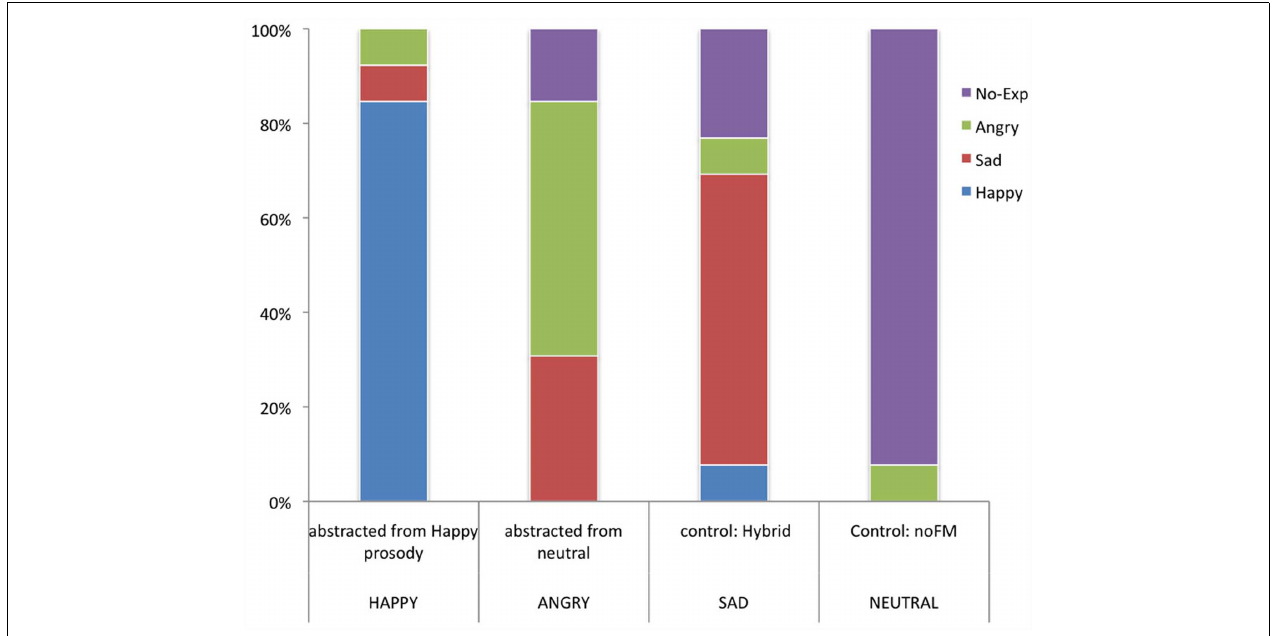
FIGURE 5 | Post recording affective judgments. YY -axis reflects the percentage of 13 subjects that endorsed a particular emotion. X -axis reflects the four stimuli presented.The top label represents the stimulus, below it is what the emotion as endorsed by the majority of